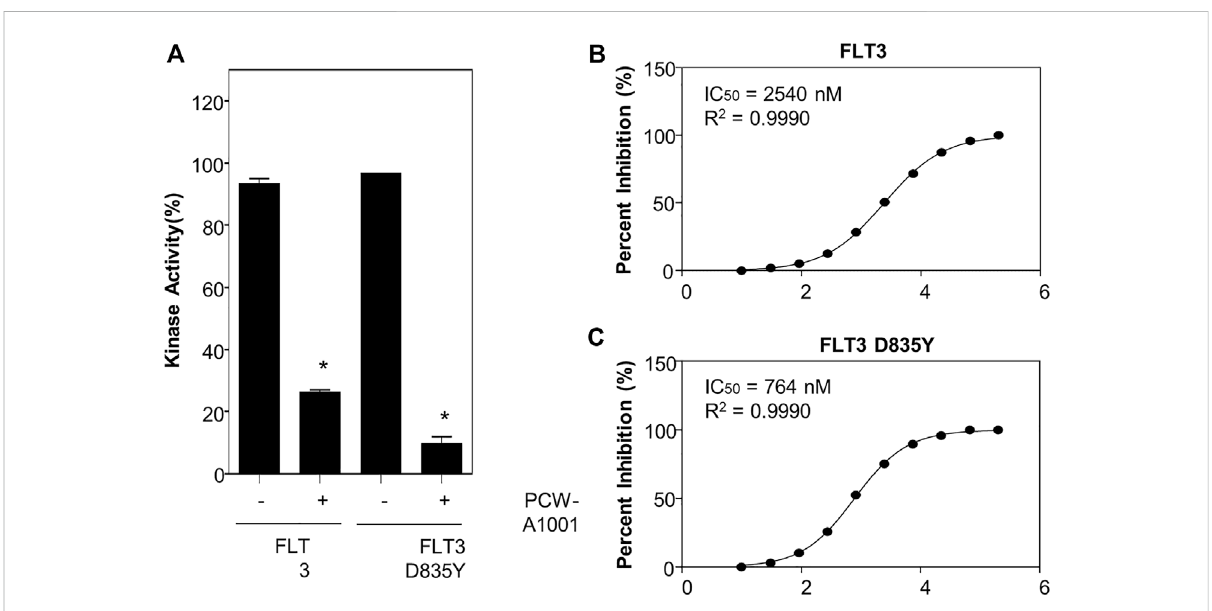
FIGURE 8 PCW-A1001 inhibits the kinase activity of FLT-3 WT and D835Y mutant. (A) PCW-A1001 inhibited FLT-3 WT and D835Y mutant kinase at 10 µM (A) . IC50 of PCW-A1001 for FLT-3 WT (B) and D835Y mutation (C) were analyzed by ThermoFisher. The data are presented as the mean ± standard error mean. * p <